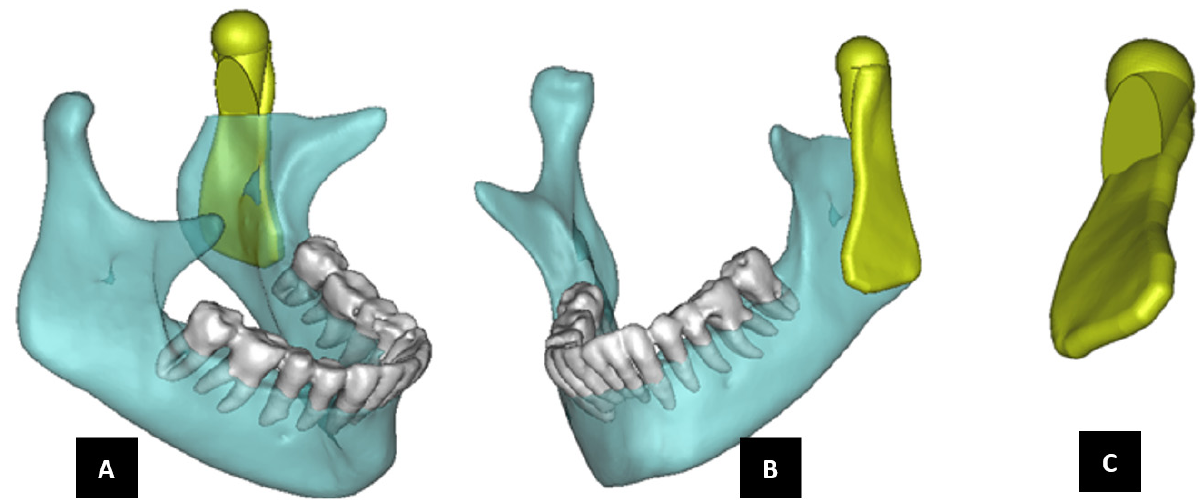
Figure 4. Shape outline of a custom-designed condylar/ramus prosthesis. ( A , B ) Show medial–anterior view and lateral–anterior view, respectively, of the prosthesis accurately adapting to the host bone. ( C ) Shows medial-inferior view of the prosthesis shape outline.